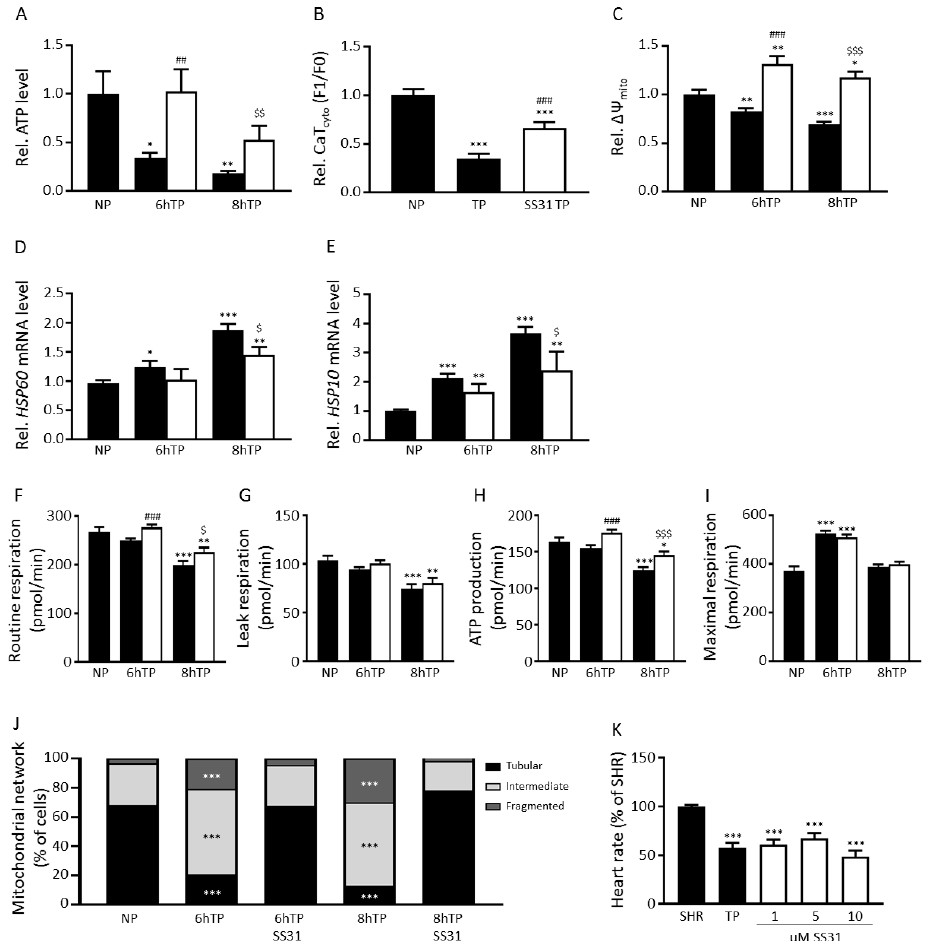
Figure 6. Treatment with SS31 protects against mitochondrial dysfunction and stress. ( A ) Quantified data showing protection of SS31 (100 nM) treatment on cellular ATP levels after normal-pacing (NP) or tachypacing (TP). Black bars represent non-treated HL-1 cardiomyocytes, white bars represent SS31-treated cardiomyocytes. ( B ) Quantified data of mitochondrial calcium transient (CaT mito ) amplitudes of HL-1 atrial cardiomyocytes after NP or TP. ( C ) Quantified data showing protection of SS31 treatment on mitochondrial membrane potential during NP and TP. Quantitative real-time PCR of mitochondrial stress markers show a slight protection of SS31 after 8h TP on ( D ) HSP60 and ( E ) HSP10 transcription levels in response to NP and TP. Black bars represent non-treated HL-1 cardiomyocytes, white bars represent SS31-treated cardiomyocytes. The oxygen consumption rate showing ( F ) routine respiration, ( G ) leak respiration, ( H ) ATP production and ( I ) maximal respiration during NP and TP with and without SS31 treatment. ( J ) The transition of the mitochondrial network from tubular to fragmented from NP to TP with and without SS31 treatment. ( K ) Quantified data showing heart wall contraction rates (heart rate) before (SHR, spontaneous heart rate) and after tachypacing (TP and white bars). Black bars represent non-treated Drosophila , white bars represent SS31-treated Drosophila . * p < 0.05, ** p < 0.01, *** p < 0.001 vs. NP or SHR, ## p < 0.01, ### p < 0.001 vs. TP (6 h), $ p < 0.05, $$ p < 0.01, $$$ p < 0.001 vs. TP (8 h).